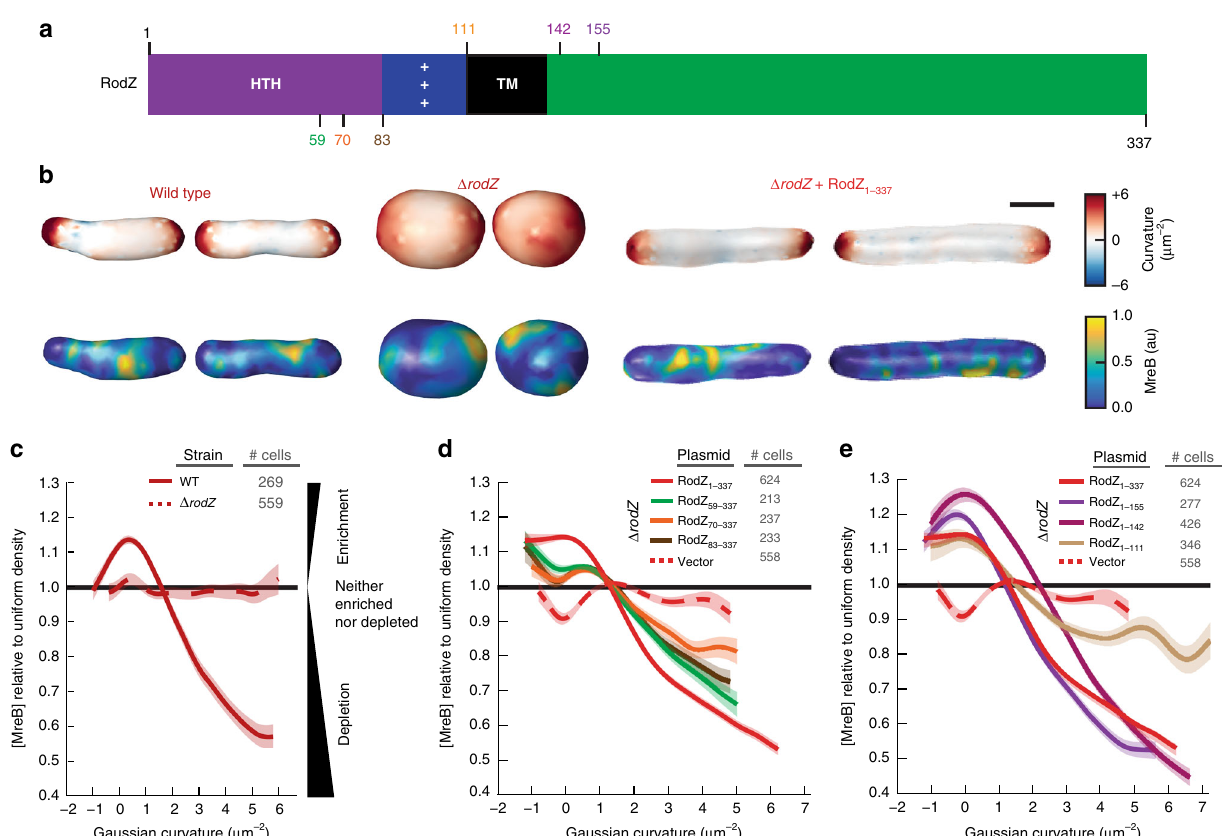
Fig. 1 The cytoplasmic domain of RodZ is necessary for MreB curvature localization. a Schematic of RodZ ’ s domain structure with location of truncations noted. b 3D images of WT, Δ rodZ , and rodZ complemented cells with Guassian curvature and MreB fl uorescence intensity represented. c MreB enrichment plot of WT and Δ rodZ . Values >1 show enrichment and <1 show depletion relative to uniform coverage of the cell. d MreB enrichment plot of RodZ cytoplasmic truncations. e MreB enrichment plot of RodZ periplasmic truncations. Shaded area indicates ± 1 standard error of the mean, and dotted lines indicate strains deleted of rodZ . c – e The curve for each strain is a cubic smoothing spline and is truncated using a probability threshold for extreme curvatures of p > 5 × 10 − 3 (Supplementary Figs. 4 and 5). Because the shape of each strain is different, the ranges of curvatures plotted for each strain are different. These experiments were performed on three separate days and the data were